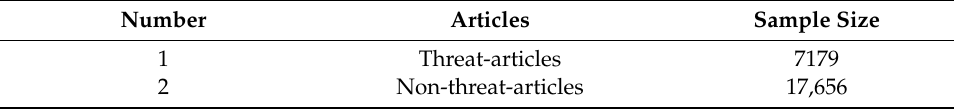
Table 4. Article samples